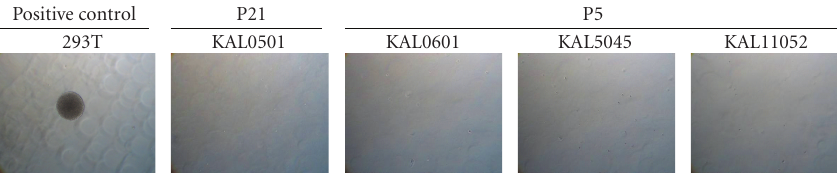
Figure 5: Picture of soft agar assay (Microscope x10). The 4 cell strains are not able to grow in soft agar after 21 days of culture on contrary to the positive control, the transformed human embryonic kidney 293T